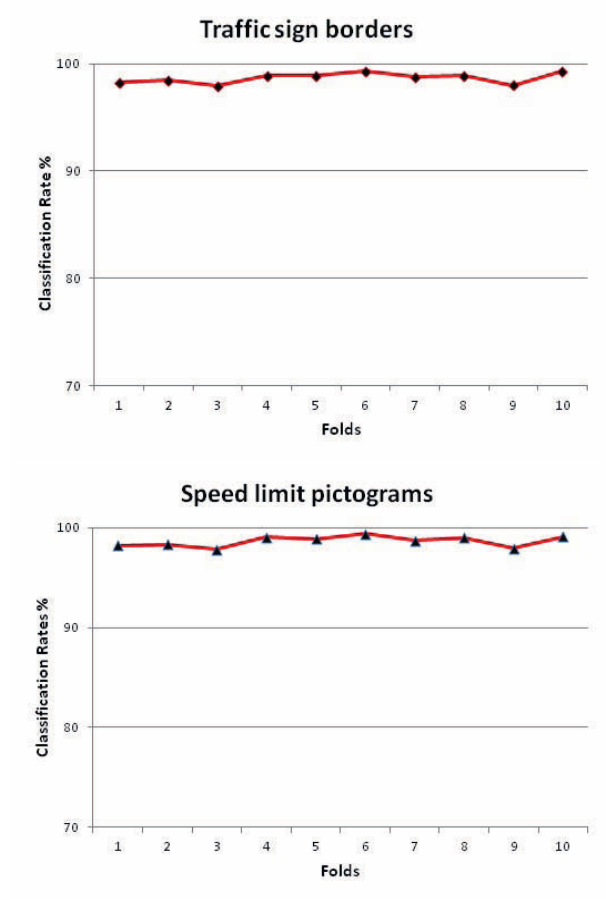
Figure 7. Classification rate. Top: traffic signs’ borders. Bottom: speed limit pic-